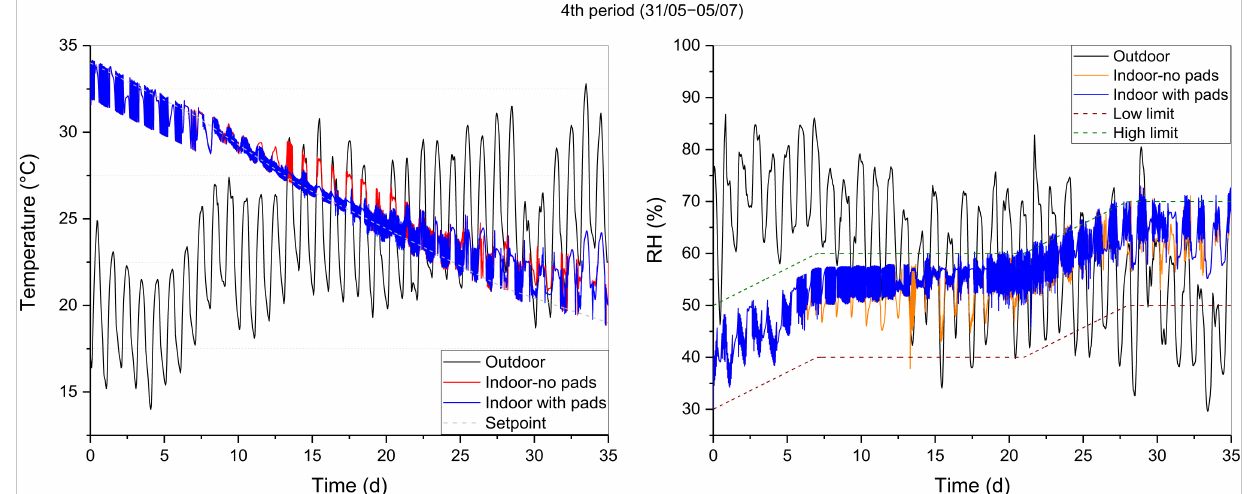
Figure 12. Temperature and relative humidity without and with evaporative pads for the 4th production period (31.05–05.07).